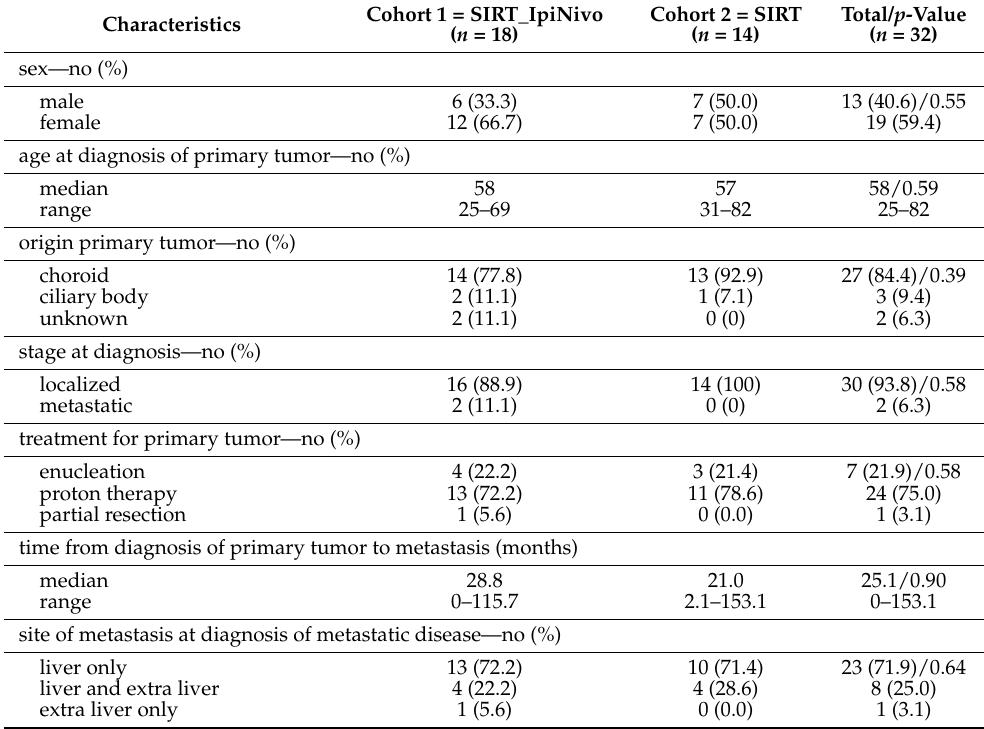
Table 1. Summary of clinical characteristics, treatment features and response to SIRT.